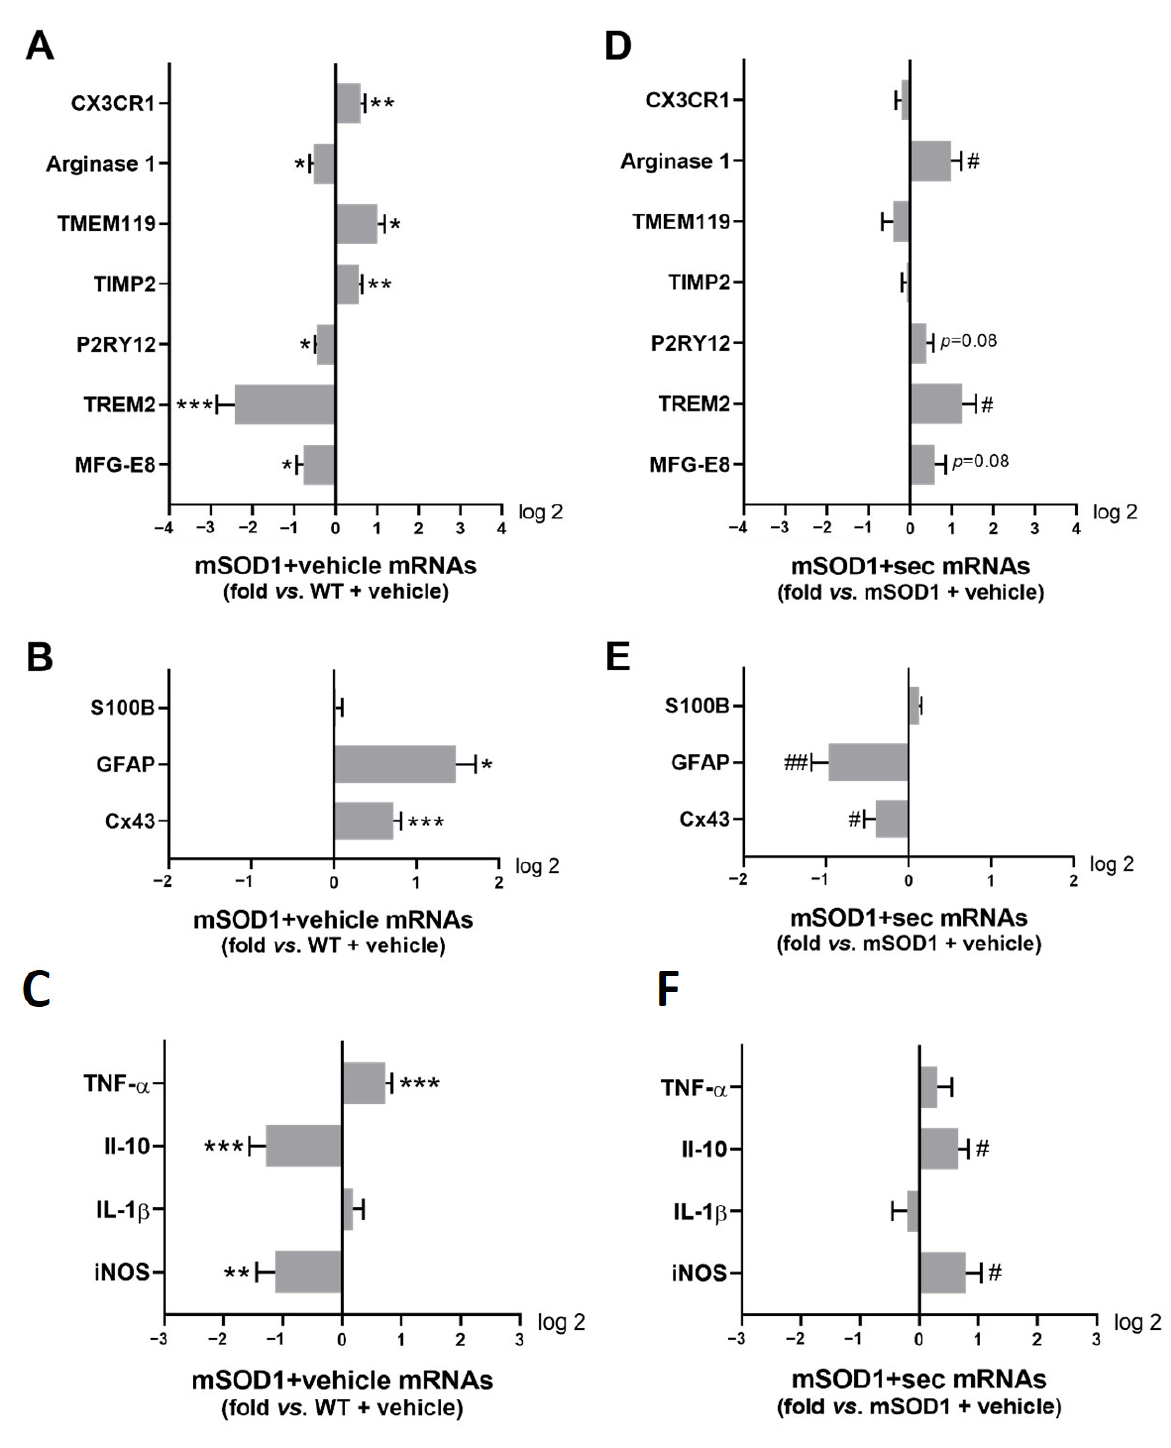
Figure 8. Intrathecal injection of the secretome from anti-miR-124-modulated mSOD1 motor neurons (MNs) in the lumbar spinal cord (SC) of mSOD1 mice at 12-week-old prevents microglia activation, astrocyte reactivity, TNF- α signalling, and inflammation associated with the symptomatic stage. Gene expression of ( A ) microglia-associated markers (MFG-E8, TREM 2, P2RY12, TIMP2, arginase 1, and CX3CR1); ( B ) astrocyte-related markers (Cx43, GFAP, and S100B); and ( C )